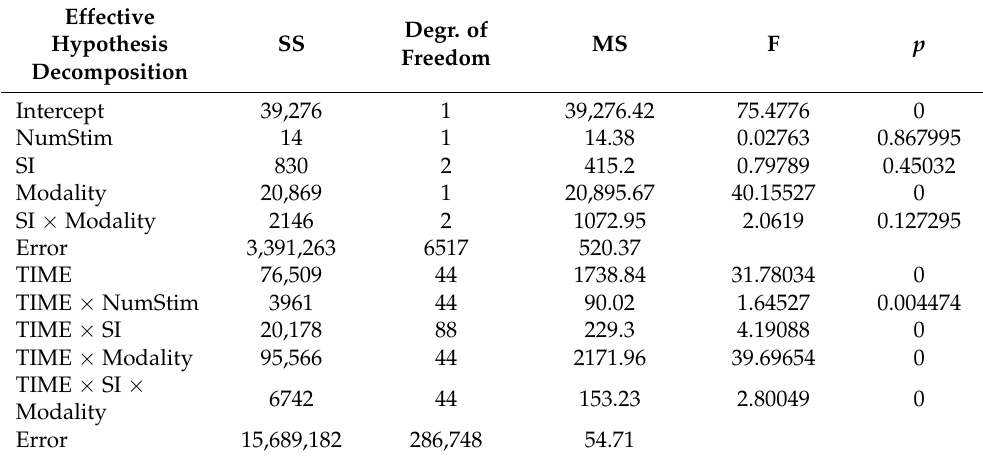
Table 4. Repeated Measures Analysis of Variance results for ERP averaged in time for Cz channel.